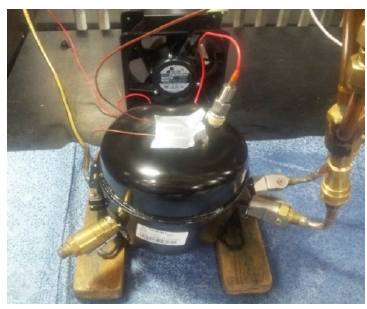
Figure 14. A single ‐ phase hermetic reciprocating compressor.